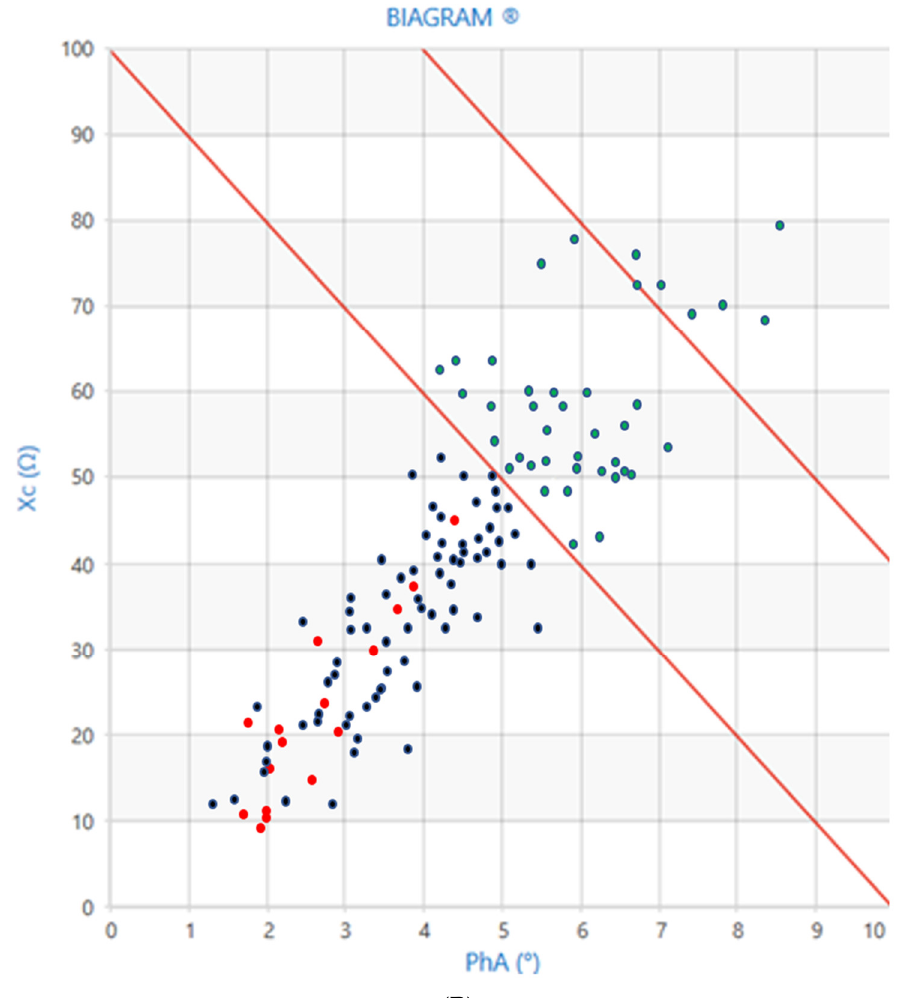
Figure 1. ( A ) Hydragram ® graph of COVID-19 disease ( n = 127). Hydration status distribution of COVID-19 admitted patients showed a situation of hyperhydration associated with COVID-19 (43.3%). ( B ) Biagram ® graph of COVID-19 disease ( n = 127): distribution of COVID-19 admitted patients. All casualties are marked with red dots. Blue dots below lower line are false positive, blue dots above lower line true negative. The position of the points is related to the E/I status of the patient based on raw measurements of reactance and phase angle. Points below the lower line are associated with states of expansion of extracellular space greater than intracellular (severe inflammatory process), between the line points are normal E/I and above the upper line extracellular is smaller than intracellular space. The entire cluster of red dots is positioned below the lower discriminating line showing above the line a 100% NPV (negative = survivors) area.